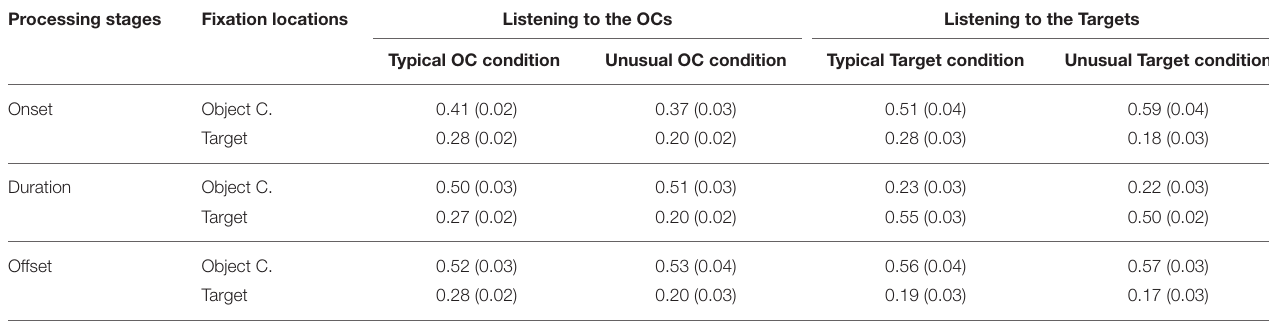
TABLE 3A | Mean proportions of fixation ( SE ) under different conditions during real time processing in Experiment 2 ( N = 31). Processing stages